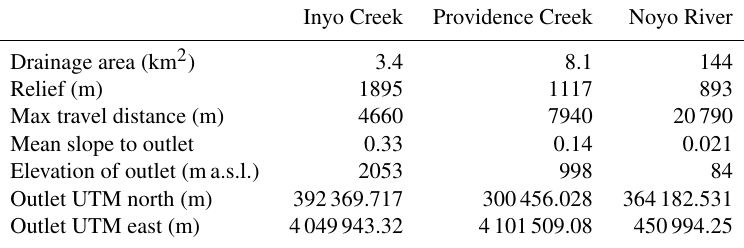
Table 1. Study site